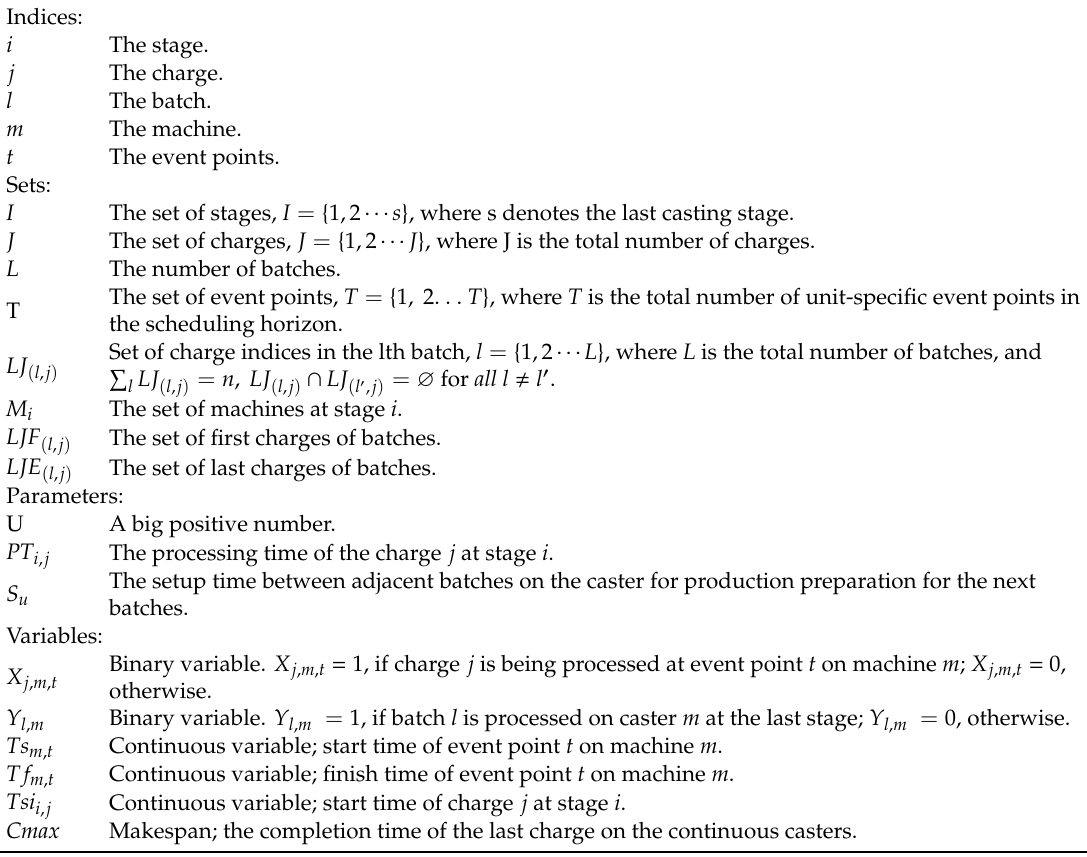
Table 1. Indices, parameters and variables of the proposed model.